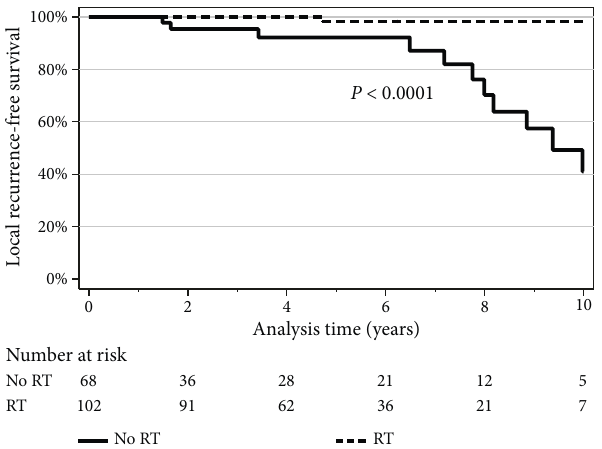
Figure 1: Local recurrence-free survival for XRT and no-XRT groups. The Kaplan–Meier curves show the local recurrence-free survival (LRFS) for the XRTgroup (dashed line) and no-XRTgroup (solid line). The 5-yr LRFS (95% CI) was 98% (88–99) in the XRT group and 92% (77–97) in the no-XRTgroup LRFS was 98% (88–99) in the XRT group and 41% (17–64) in